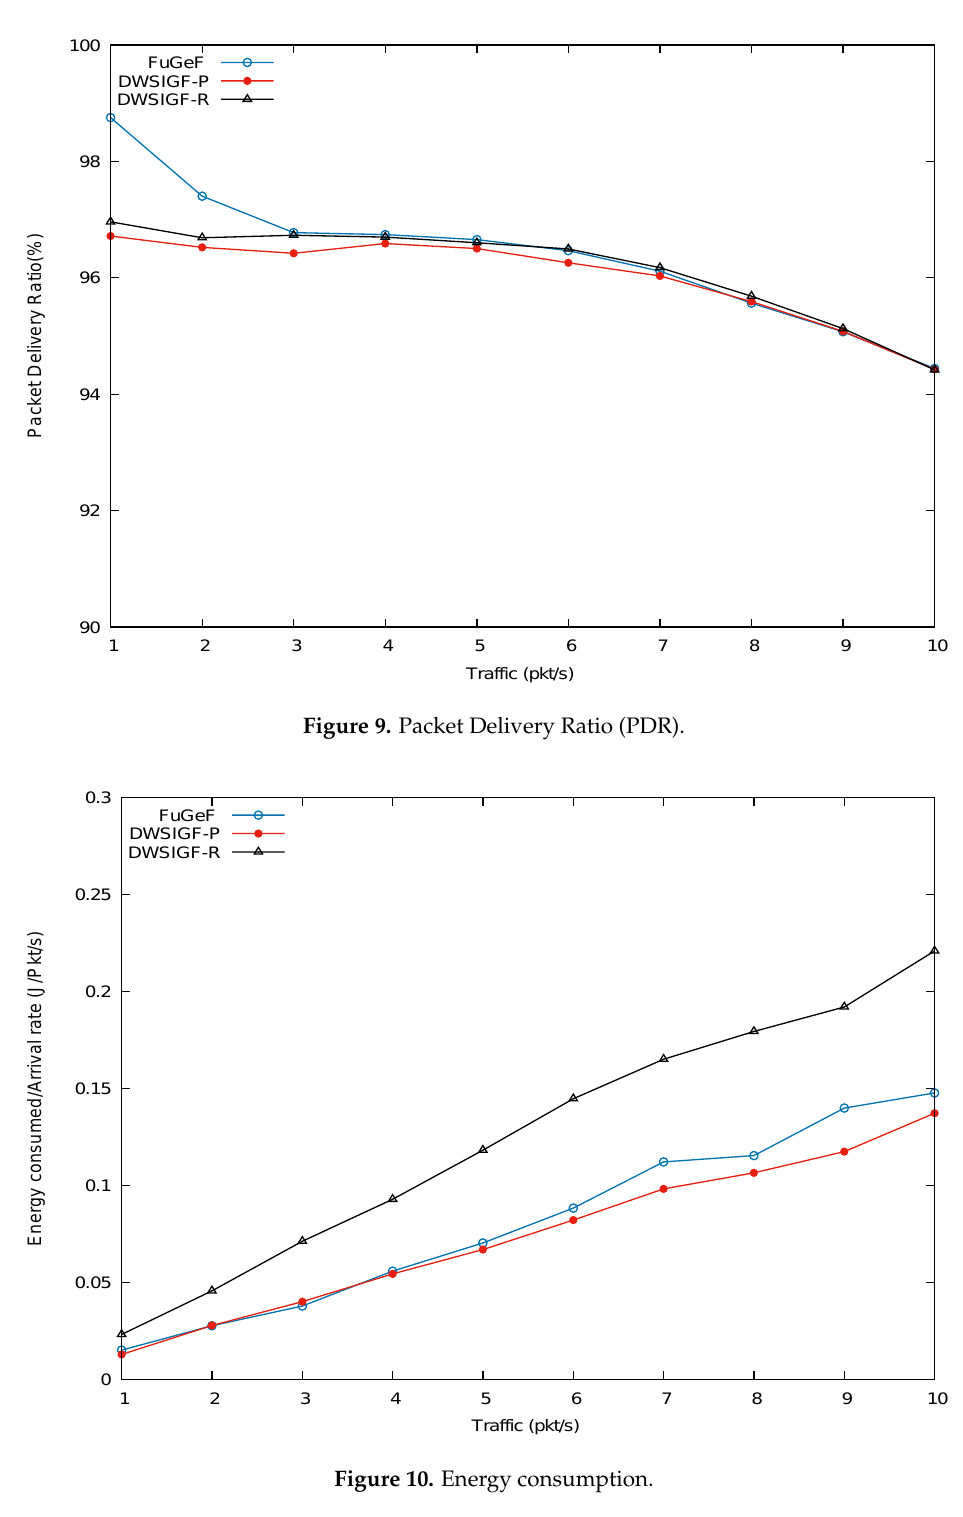
Figure 10. Energy